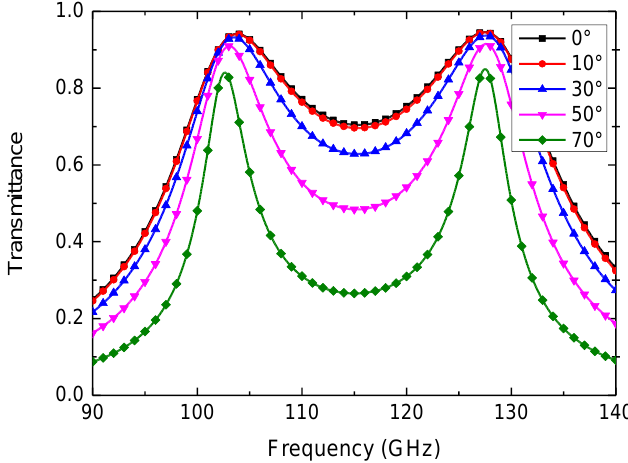
Figure 4. Oblique incidence response of the proposed structure.